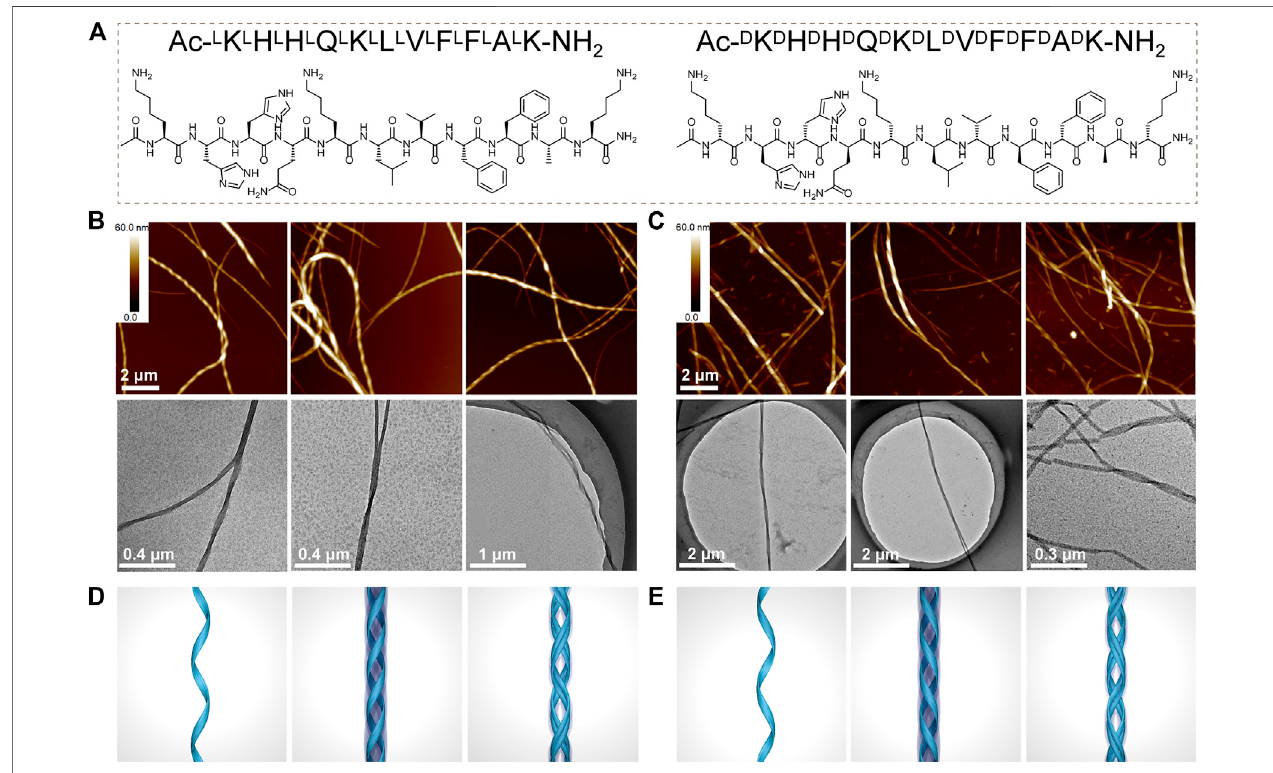
FIGURE 1 | (A) Chemical structures of Ac- L K L H L H L Q L K L L L V L F L F L A L K-NH 2 (KK-11) and Ac- D K D H D H D Q D K D L D V D F D F D A D K-NH 2 (KKd-11). (B, C) AFM and TEM images of the assembled nano fi brils formed by KK-11 (B) and KKd-11 (C), respectively. (D, E) Sketch maps of helical nano fi brils formed by KK-11 (D) and KKd-11